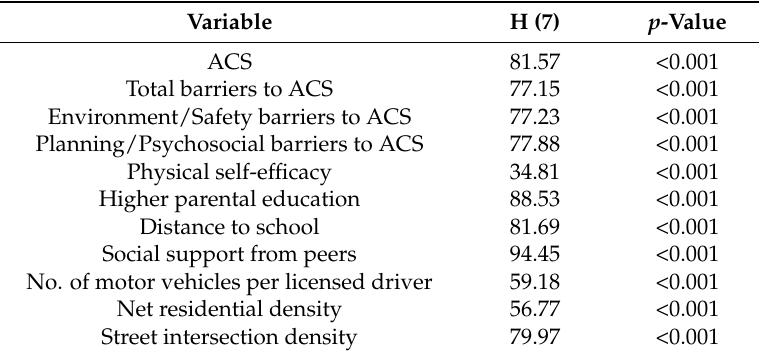
Table 2. Results of Kruskal–Wallis